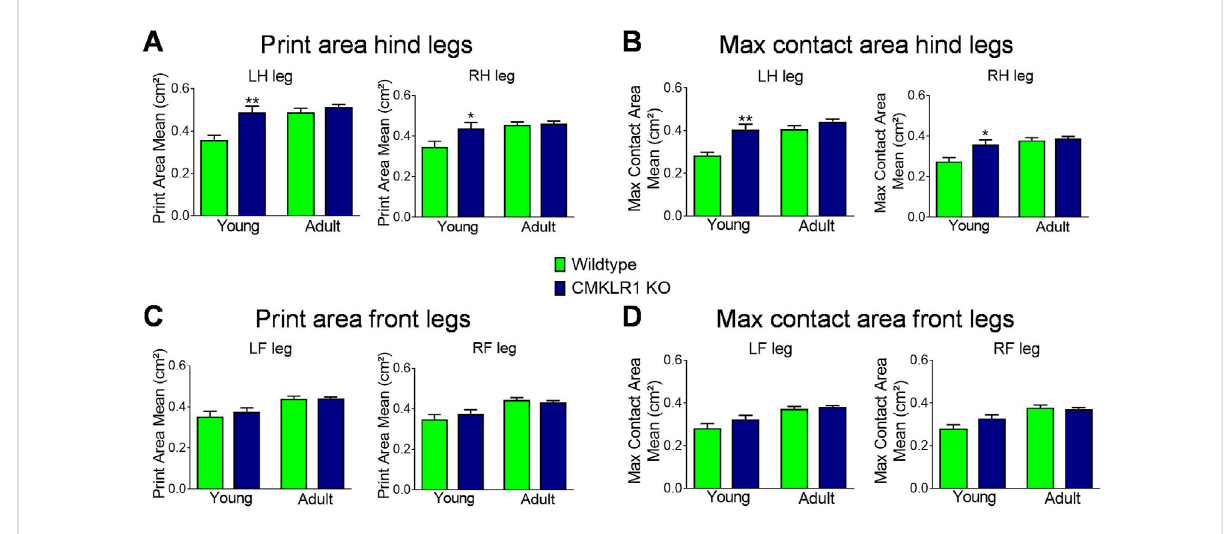
FIGURE 2 CMKLR1 inhibition alters mobility parameters Print area mean (A) and maximum contact area (B) of the hind legs of wild type and CmklR1 KO mice at young and adult stage. Print area mean (C) and maximum contact area (D) of the front legs of wild type and CmklR1 KO mice at young and adult stage Values are expressed as means ± SEM; *: p < 0.05, **: p < 0.01, versus wild type control mice by unpaired t -test; n = 7 – 12 per